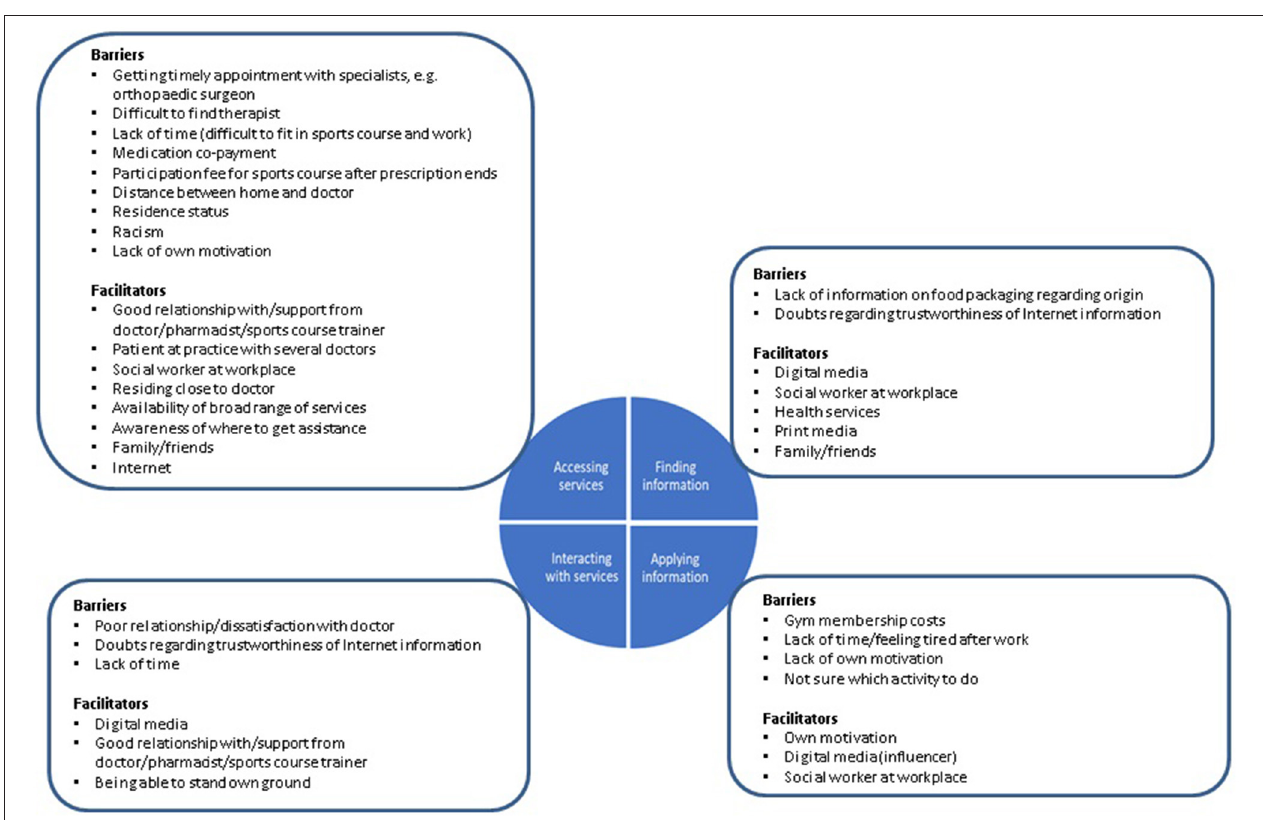
FIGURE 2 | Barriers and facilitators regarding the health literacy components identified from interview